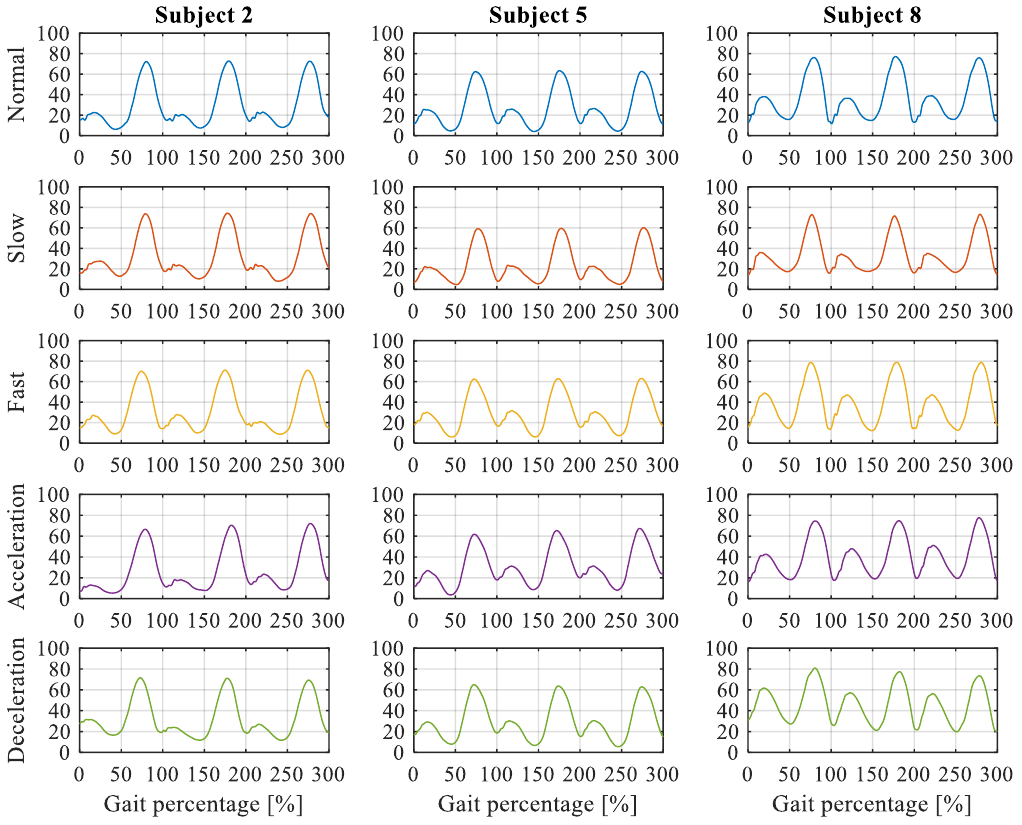
Figure 6. Knee angles of subject 2, 5 and 8 in different walking conditions.